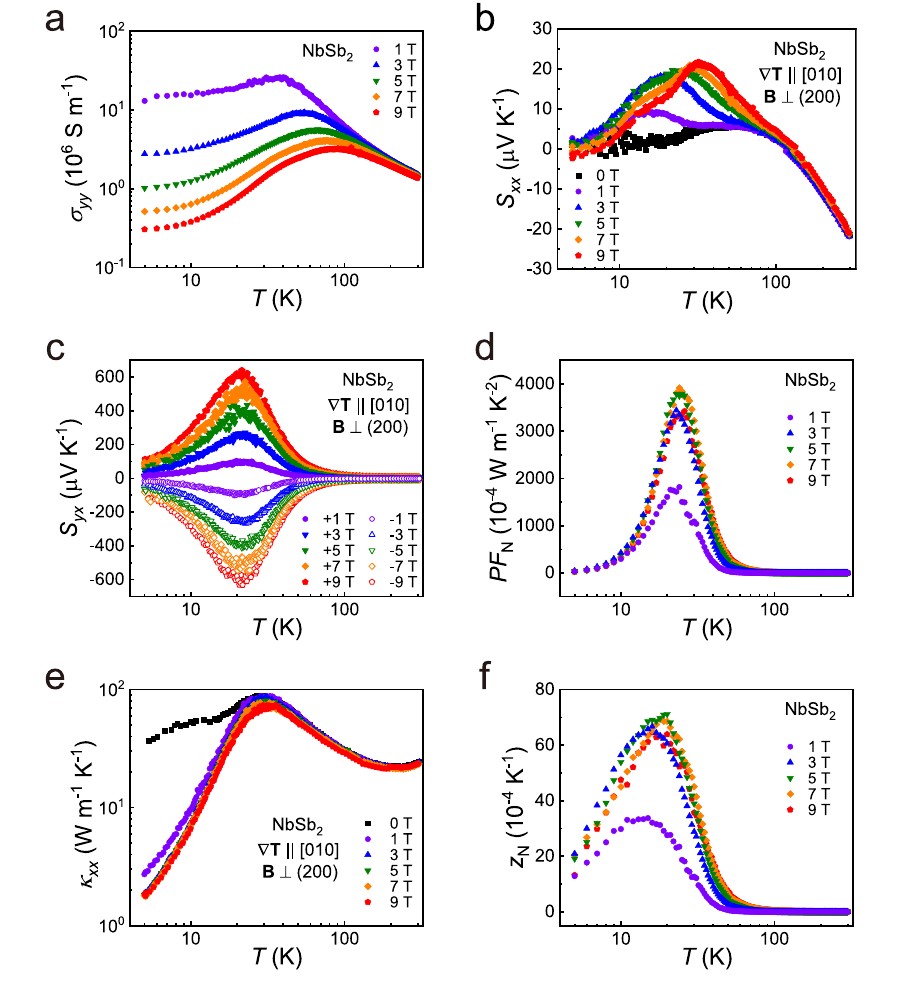
Fig. 3 | Electrical and thermal properties of NbSb 2 for Ettingshausen refrig- eration. Temperature dependences of a electrical conductivity ( σ yy ), b Seebeck thermopower ( S xx ), c Nernst thermopower ( S yx ), d Nernst power factor ( PF N ), e transverse thermal conductivity ( κ xx ), and f Nernst fi gure-of-merit ( z N ) of